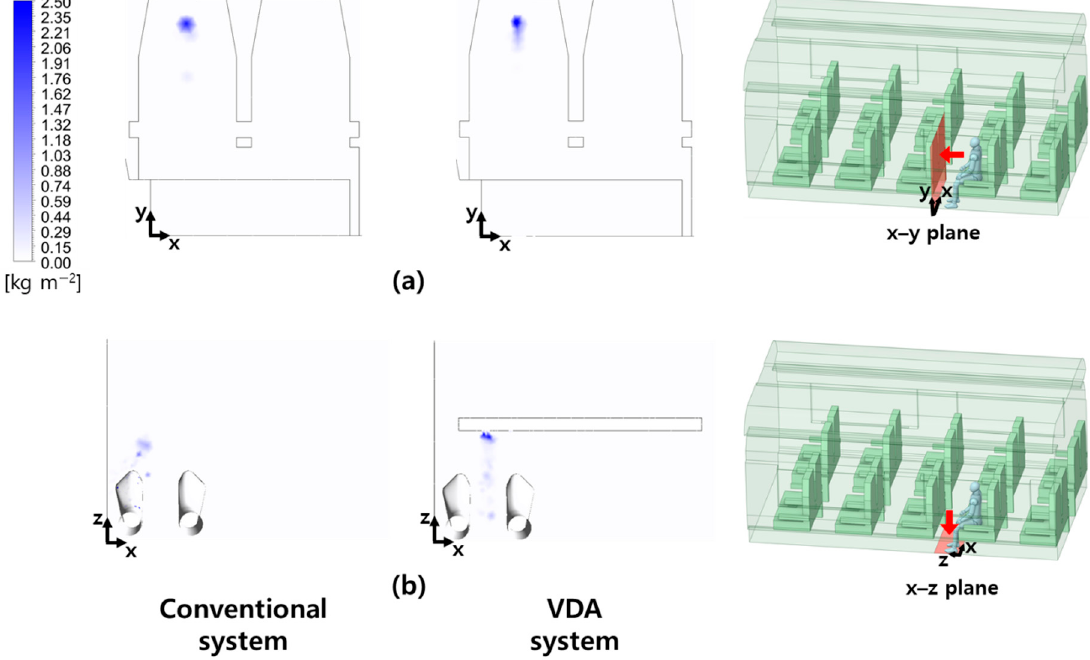
Figure 9. Droplet deposition distributions in the conventional and VDA systems ( a ) at the back surface of the front seat and ( b ) on the floor under the seat.